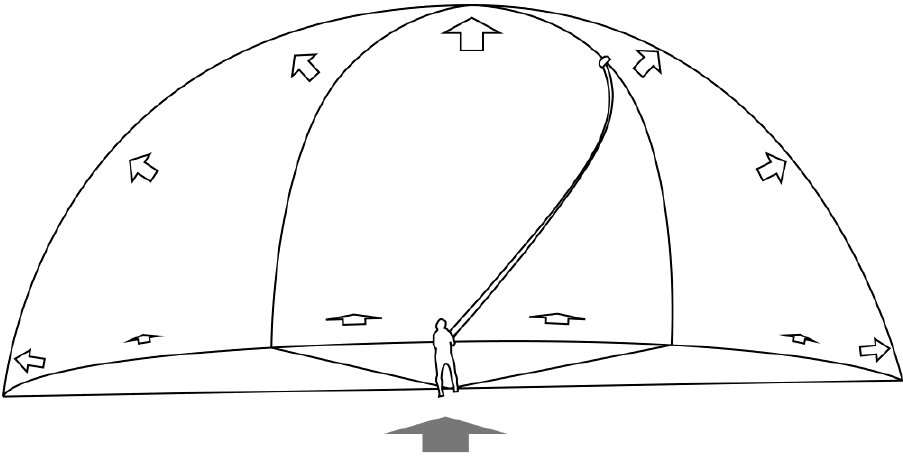
Figure 6. The wind window: grey arrow indicating the wind direction and white arrows all possible kite movement.